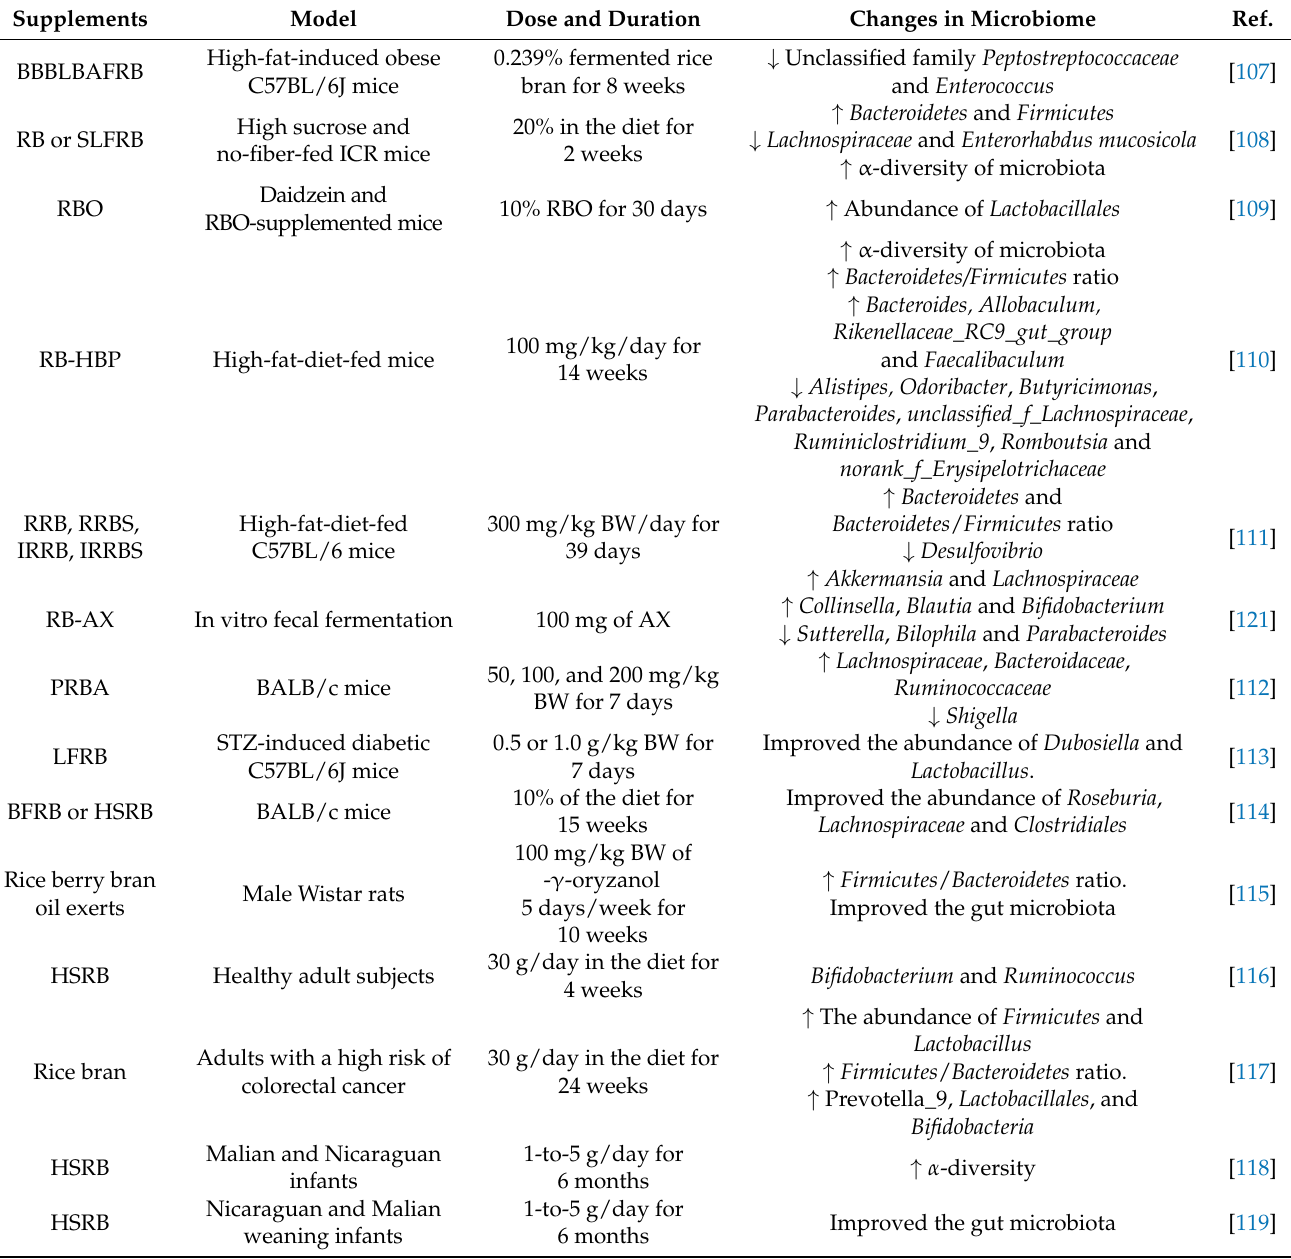
Table 4. The influence of rice bran and rice bran derivatives on host